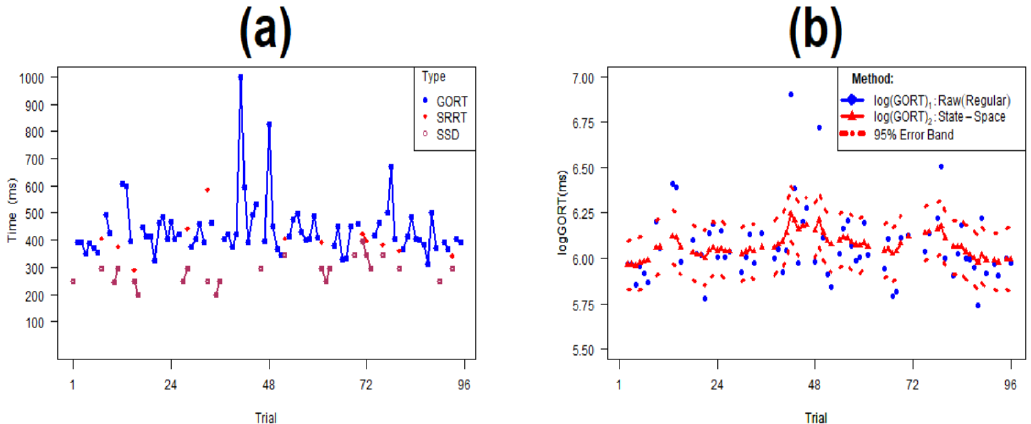
Figure 4. ( a ) 3-variables time series plot of the Standard Stop Signal Task (SSST) data; ( b ) Estimation of time series-based state-space log (GORT) for the GORT data in the panel ( a